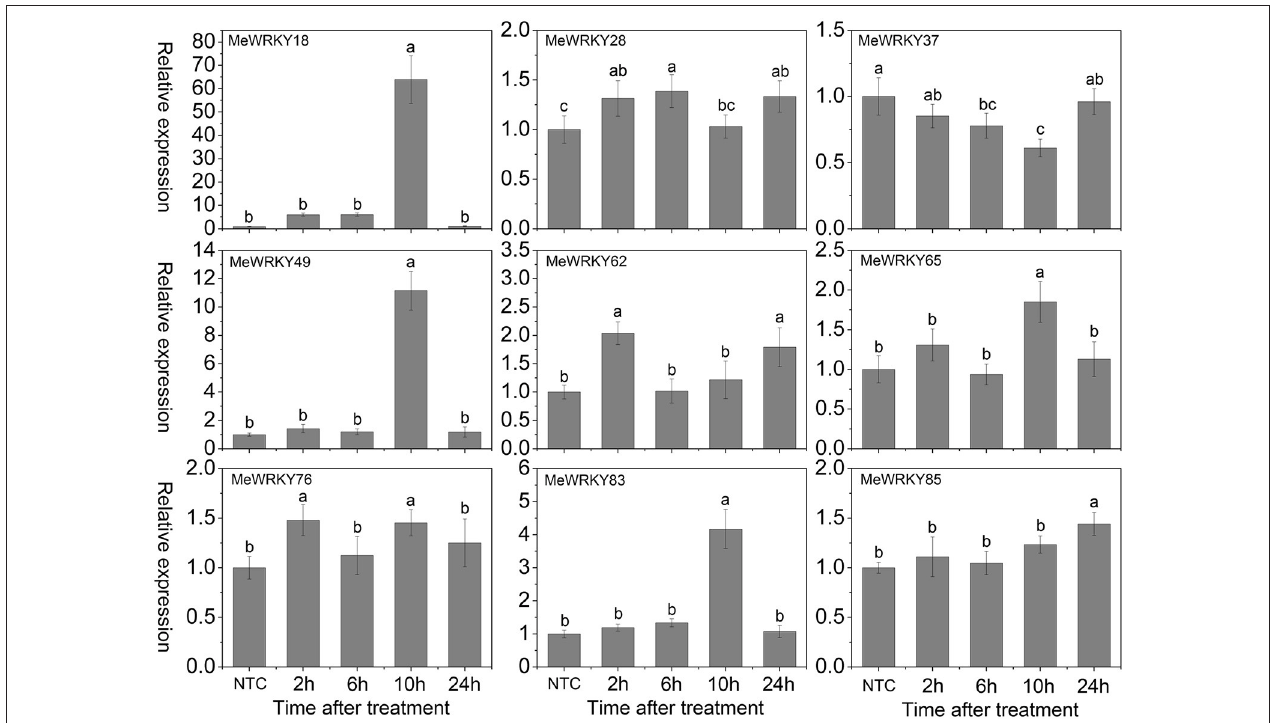
FIGURE 10 | Expression profiles of MeWRKY genes in leaves under ABA treatment. The relative expression levels of MeWRKY genes in each treated time point were compared with that in each time point at normal conditions. NTC (no treatment control) at each time point was normalized as “1.” Data are means ± SE calculated from three biological replicates. Values with the same letter were not significantly different according to Duncan’s multiple range tests ( P < 0.05 , n = 3 ).